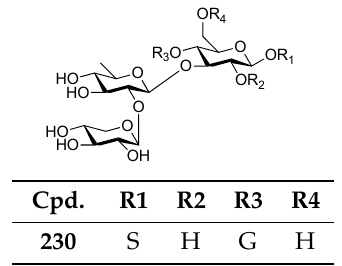
Figure 42. Structure of compound 229 . Molecules 2016 , 21 , 1402